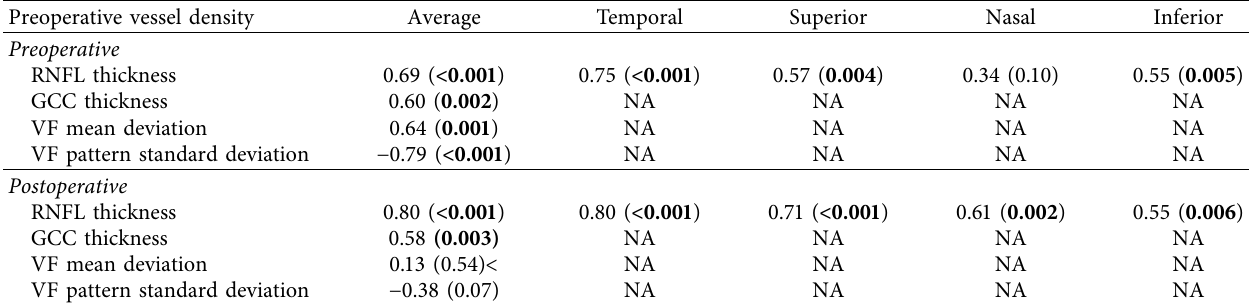
Table 5: Spearman’s correlation coefficient ( r ( p value)) of vessel density with pre- and postoperative structural and functional char- acteristics in patients with chiasmal